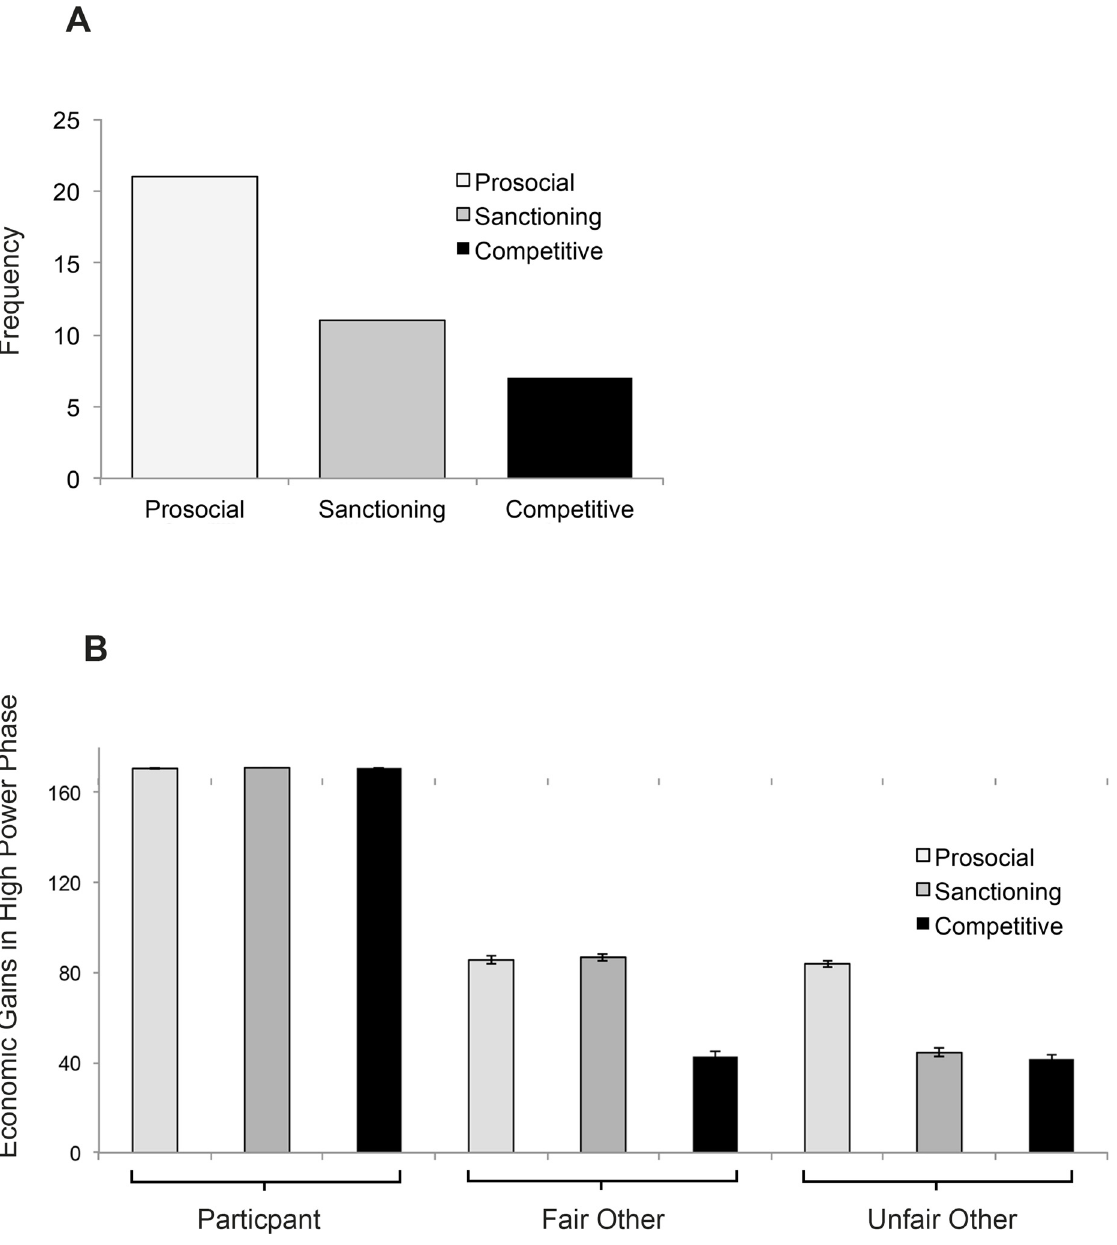
Fig 4. Participants ’ behavior in the high power phase of the Inequality Game. (A) Classification of participants based on their economic choices in the high power phase and (B) hypothetical economic gains in the high power phase for each player split by inter-individual classification of participants. Chart A depicts frequencies; Chart B depicts means and 2 standard errors of the mean. *** p < .001; ** p <